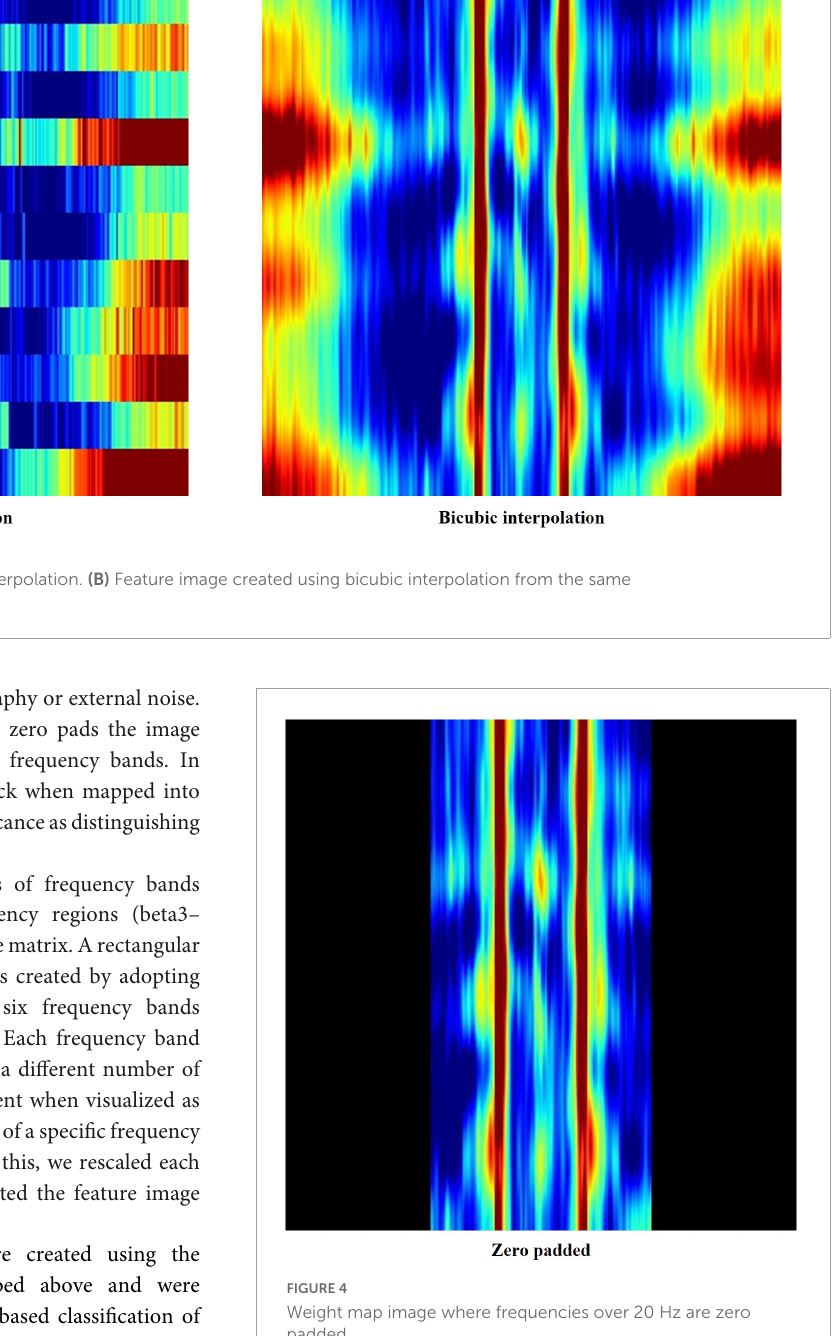
FIGURE4 Weight map image where frequencies over 20 Hz are zero